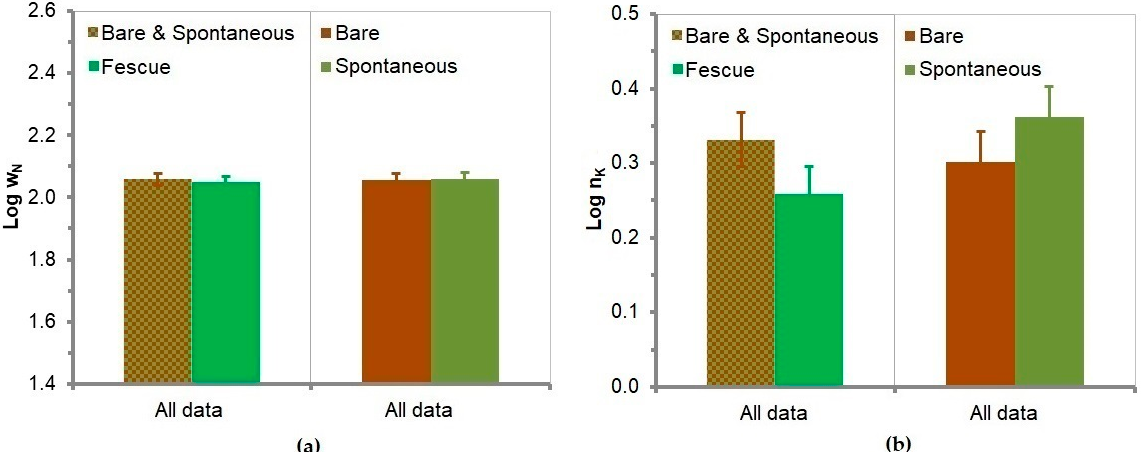
Figure 9. ( a ) logarithm to base 10 of the soil nitrogen mass fraction ( w N ) at 0–20 cm in the different treatments alongside the 95% confidence interval for the means according to the orthogonal contrasts based on the two-way ANOVA results; ( b ) logarithm to base 10 of the soil exchangeable potassium concentration ( n K ) at 0–20 cm in the different treatments alongside the 95% confidence interval for the means according to the orthogonal contrasts based on the two-way ANOVA results.